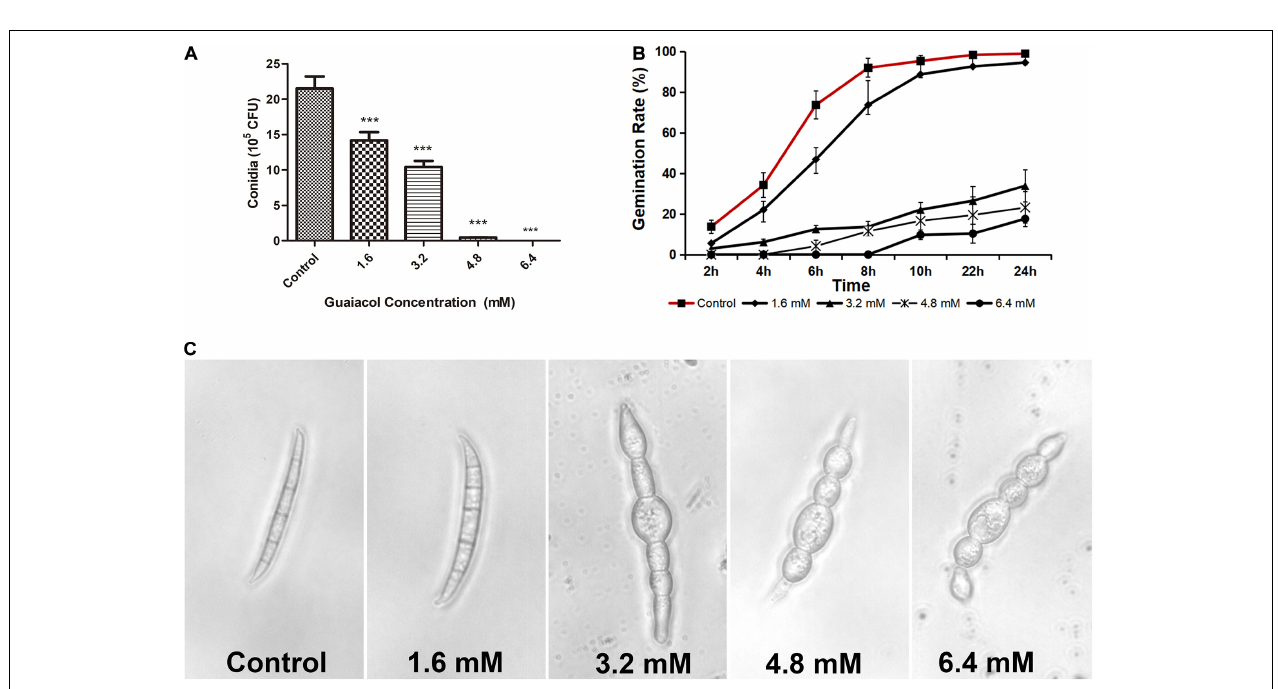
FIGURE 1 | Guaiacol inhibits the mycelial growth of F. graminearum . (A) Strain PH-1 was cultivated on PDA plates containing guaiacol (0–6.4 mM) for 3 days for photographing and the measurement of the diameter of colonies; (B) SEM observation of the hyphal morphology of F. graminearum (PH-1) under guaiacol (0–16 mM)